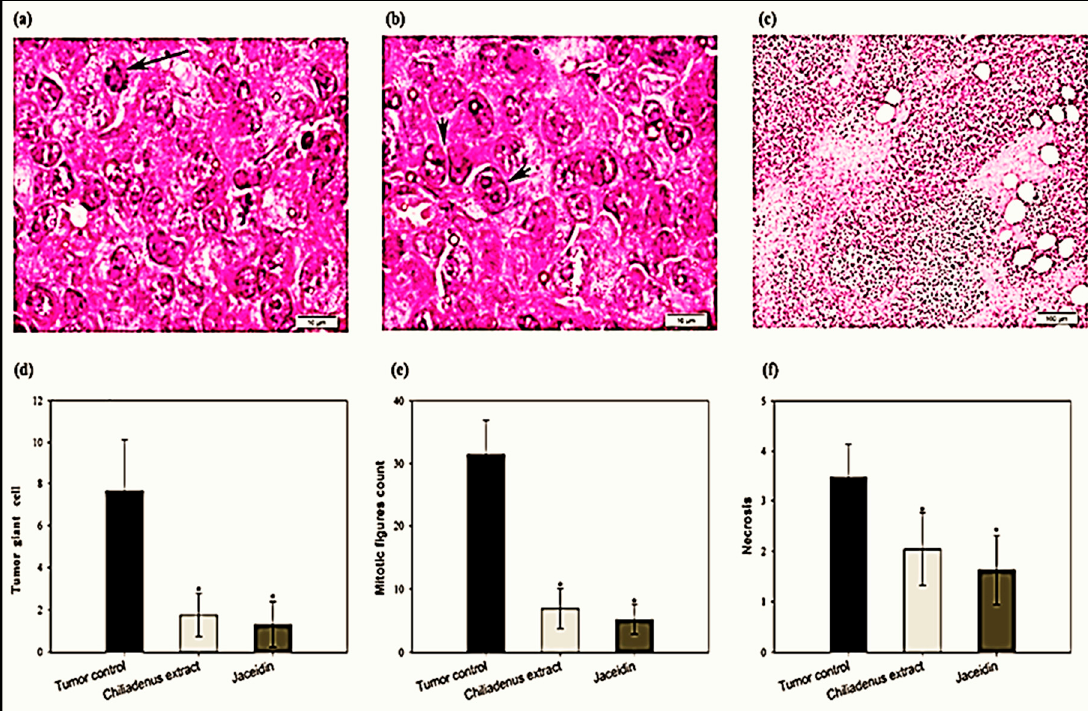
Figure 3. Effect of Chiliadenus montanus extract and jaceidin on tumor giant cell count ( a , d ); mitotic picture ( b , e ) and necrotic area ( c , f ) on Ehrlich’s carcinoma solid tumors growing in female mice. Data are expressed as the mean ± SD and analyzed using one-way ANOVA followed by Bonferroni’s post-hoc test. * compared to the tumor control group at p < 0.001.